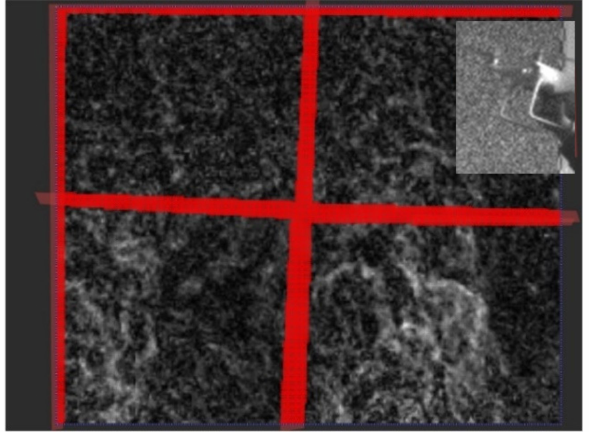
Figure 15. Displacement grayscale diagram of UAV flow